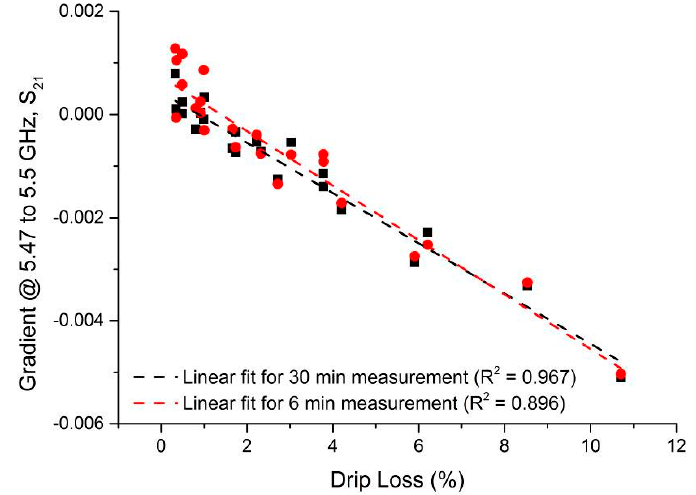
Figure 10. Correlation of the microwave cavity sensor when sample is measured for 30 min (R 2 = 0.967) and 6 min (R 2 = 0.8955).